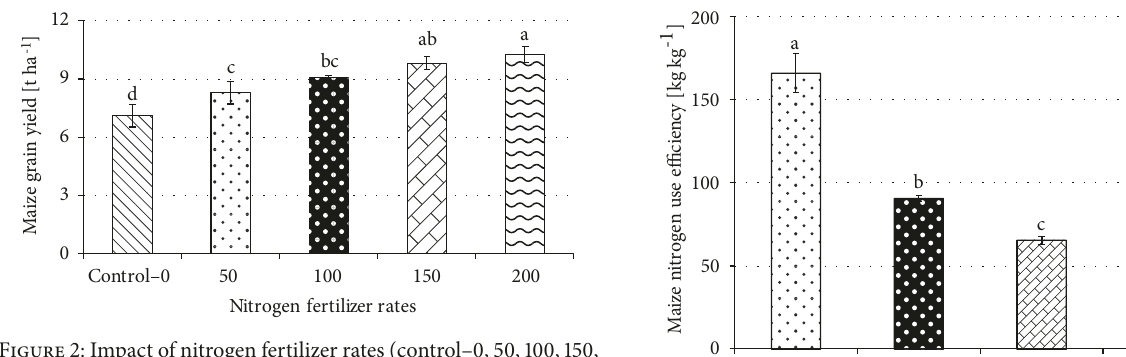
Figure 2: Impact of nitrogen fertilizer rates (control–0, 50, 100, 150, and 200kg ha −1 ) on maize grain yield (Mean ± SD). Values across N fertilizer rates with different letters are significantly different ( P < 0.05).